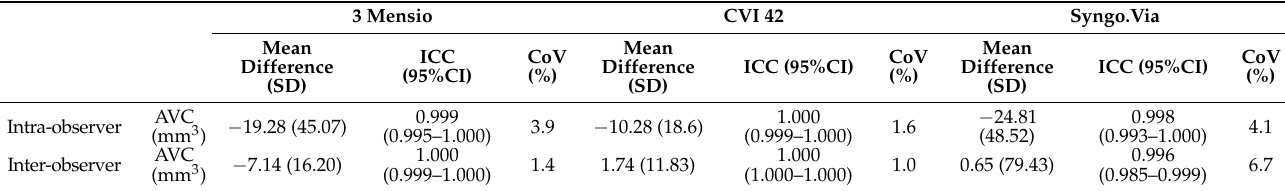
Figure 5. Bland-Altman plots for intra- and inter-observer agreement. The intra- and interobserver agreement on the degree of AVC. Bland-Altmann plots with limits of agreement (95% confidence intervals) demonstrate the reproducibility of MDCT-derived AVC using three different software solutions. The data for inter-observer reproducibility were derived by a second skilled observer. MDCT: multidetector computed tomography; AVC: aortic valve calcification. Table 3. Intra- and inter-observer agreement and reproducibility .